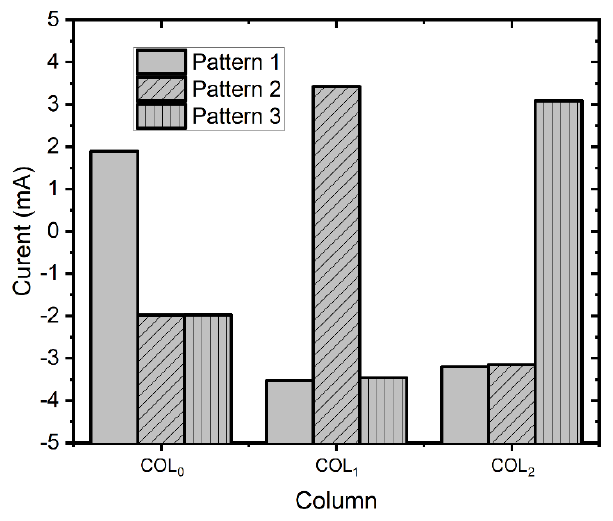
Figure 9. The measured column currents for the three input patterns.